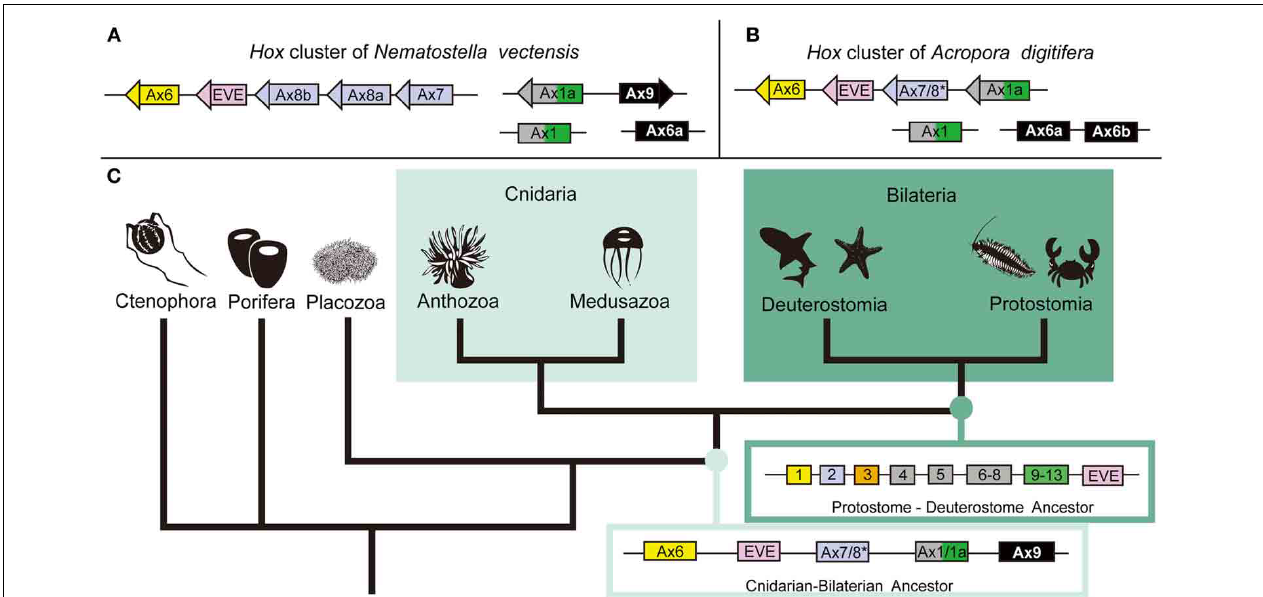
FIGURE 2 | The anthozoan complement of Hox genes and the implications of the evolution of the Hox cluster. Comparing the genomic linkage of Hox genes in the sea anemone N. vectensis and the staghorn coral A. digitifera confirms that cnidarians once had a Hox cluster that contained both anterior and posterior/central class Hox genes. (A) The Hox cluster of N. vectensis includes the anterior Hox genes Anthox6 (PG1), Anthox8b (PG2), Anthox8a (PG2), and Anthox7 (PG2) as well as the Eve homeobox gene. (B) The Hox cluster of A. digitifera includes the anterior Hox genes Anthox6 (PG1) and Anthox7/8 (PG2), and the posterior/central class Hox gene Anthox1a (PG4–14), as well as the Eve homeobox gene. Another gene HlxB9 (also named MNX) is found upstream of Anthox6 in the Hox cluster of both genomes (data not shown). (C) The metazoan tree of life with inferred ancestral Hox clusters. The ancestor to protostomes and deuterostomes is thought to have had two anterior class Hox genes (Hox1 and Hox2), one